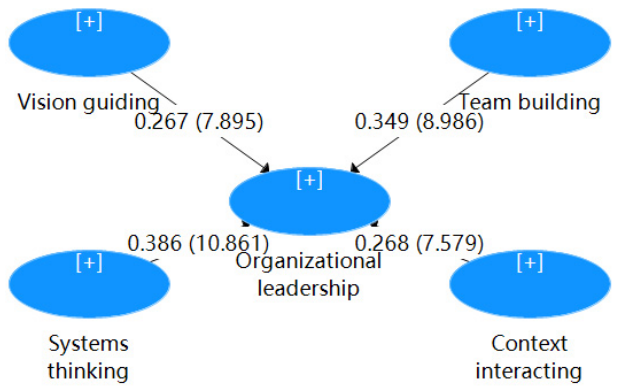
Figure 2. Structural model of dimensions of OL. Table 6. Assessments of formative dimensions of organizational leadership.